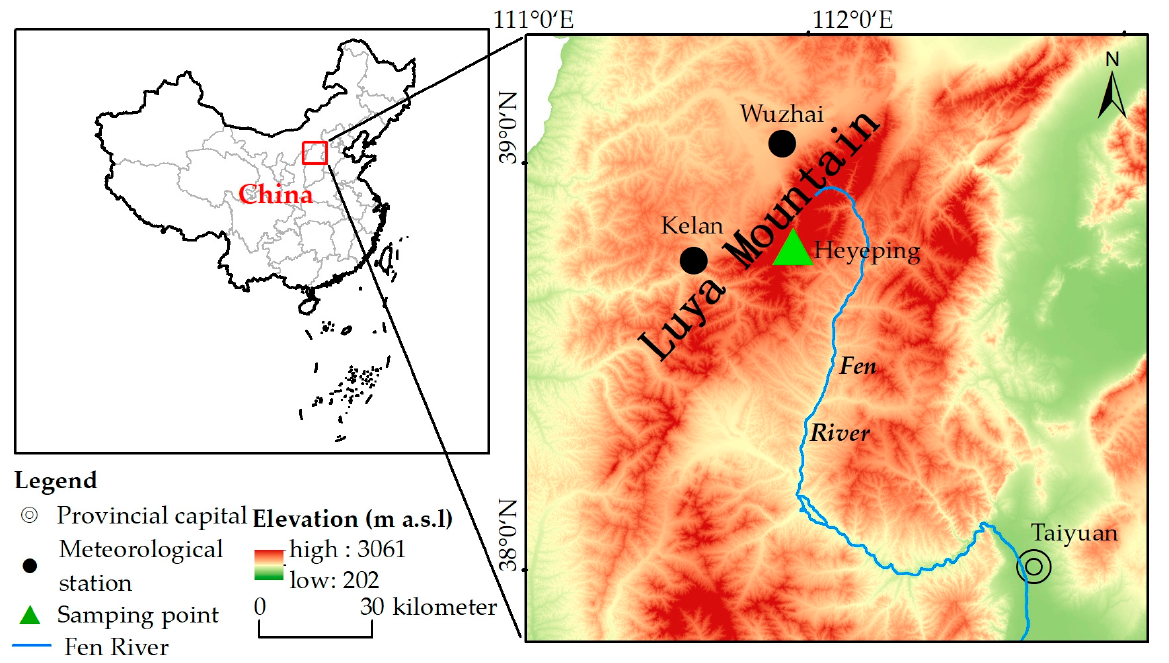
Figure 1. Distribution of meteorological station and tree ring sample sites.